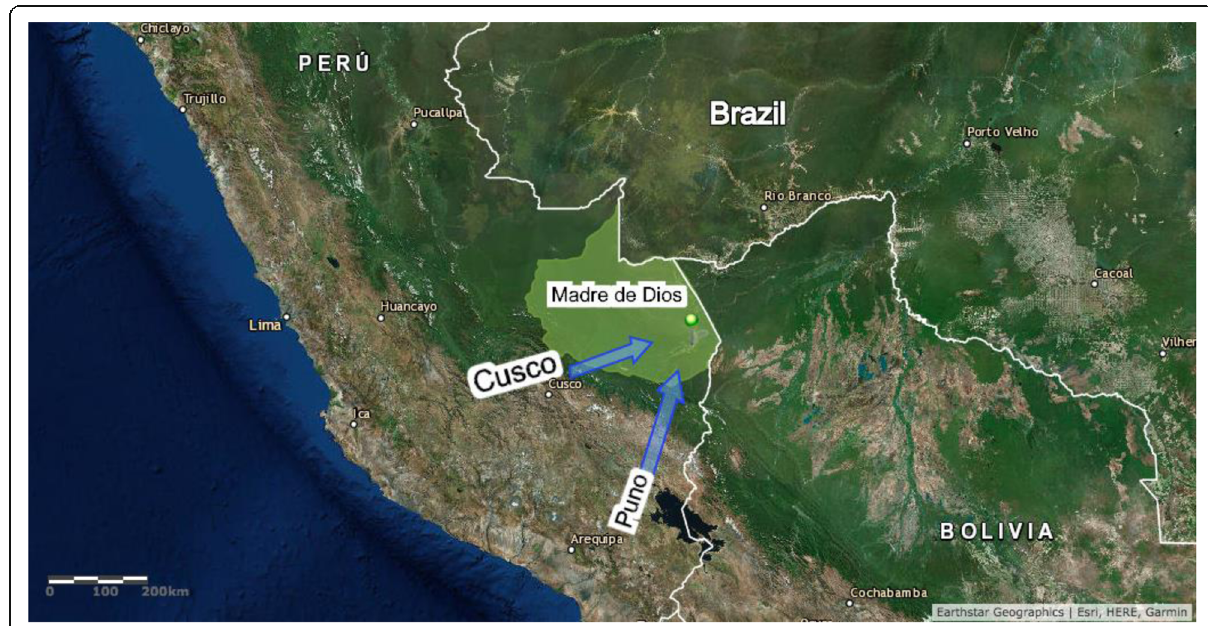
Fig. 1 Map illustrating the major migration patterns to Madre de Dios following the construction of the Interoceanic Highway. Created Using: ArcGIS Online [Internet]. Redlands, CA: Environmental Systems Research Institute (ESRI); Available from: